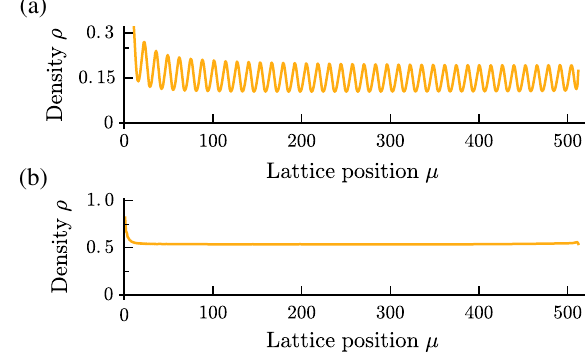
FIG. 7. Phase diagram for the special case W ¼ 2 , L ¼ 4096 , FIG. 8. Density profiles ρ μ for large and small system widths W and δ ¼ 1 = 2 . Colors denote density (left panel, blue) and current compared to the length L ¼ 512 . (a) The stationary density (right panel, orange) obtained from stochastic simulations. Three distribution for W ¼ 13 lanes shows an oscillatory pattern with a different phases can be identified: the LD phase where current wavelength equal to the number of lanes. The system exhibits a and density only depend on the in rate, the HD phase where constant current despite the density oscillations. (b) Stationary current and density only depend on the out rate, and the MC density distribution for W ¼ 2 lanes. The system exhibits a flat phase that is independent of both boundary parameters. The density profile within the bulk. Other parameter values include theory (bold lines) accurately predicts the phase boundaries and is α ¼ 0 . 6 , β ¼ 0 . 2 , and δ ¼ 1 = 2 in both valid for general δ and W as soon as the maximal density is known. Here, ρ was taken from the analytic approach (see max Appendix A).